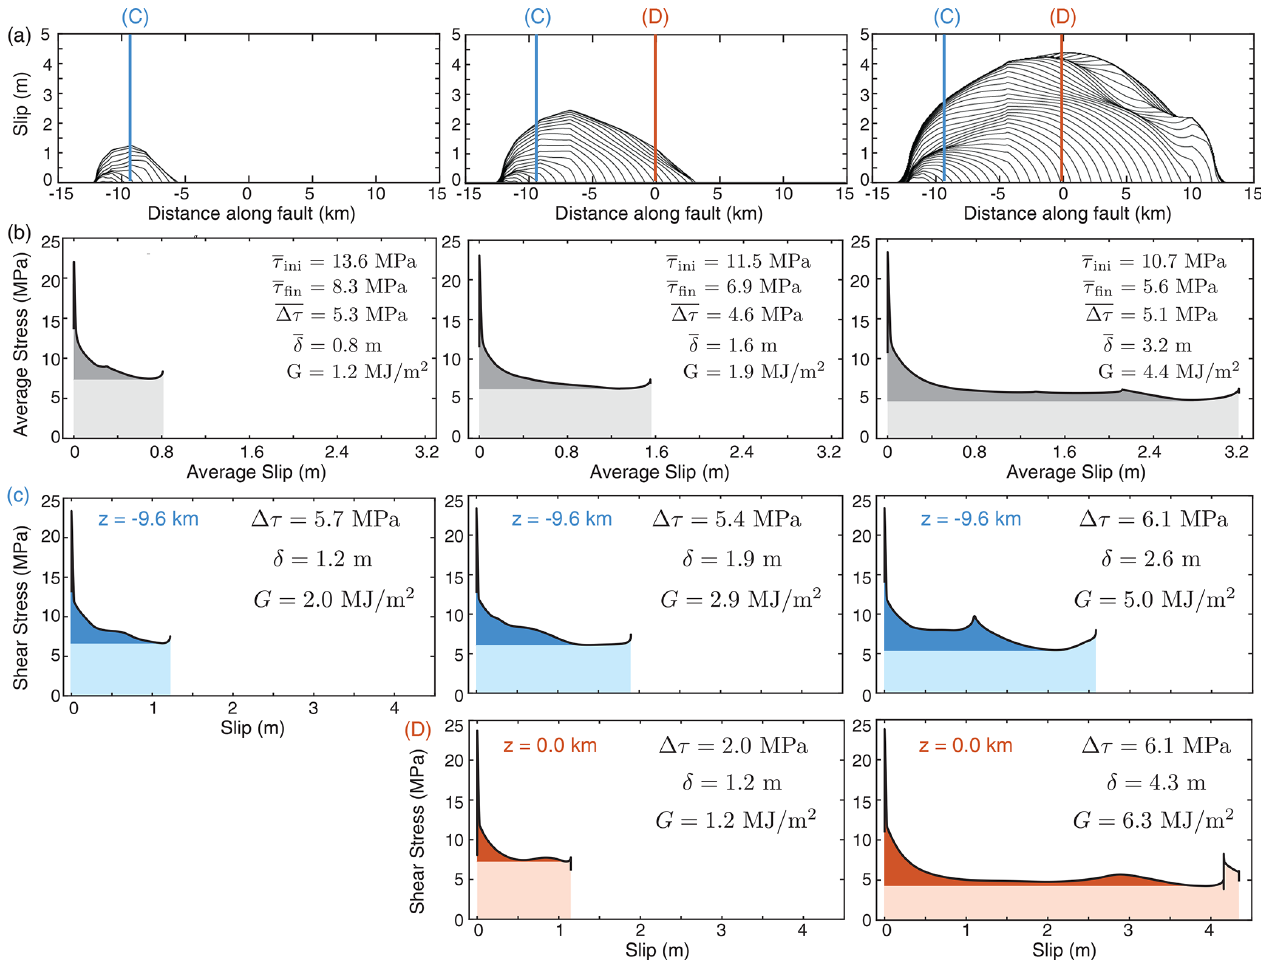
Figure 6. The dependence of shear stress on slip for the three ruptures of Fig. 5. (a) Slip distributions with the locations that are examined in detail marked. (b) Average shear stress vs. slip curves, illustrating the energy partitioning of the ruptures based on the averaging method- ology of Noda and Lapusta (2012) that attempts to preserve local rupture behavior. The curves capture the continuous weakening with slip experienced by most rupture locations. (c, d) Local shear stress vs. slip curves at two points within the three ruptures, illustrating the general trend in increasing breakdown energy with increasing slip at the same